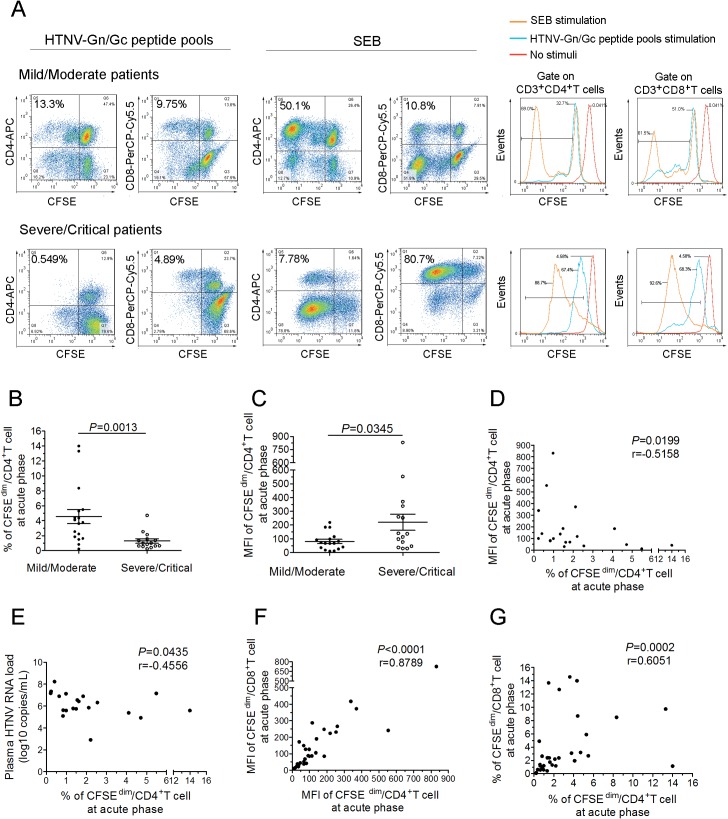
The expansion capacity of HTNV-Gn/Gc-specific CD4+T cells is associated with viremia control in HFRS patients.(A) Representative flow cytometric plots of the expansion percentage of CD4+ or CD8+T cells stimulated by the HTNV-Gn/Gc or polyclonal activator SEB control during acute HFRS. The expansion extent of the HTNV-Gn/Gc-specific CD4+ or CD8+T cells is shown in the upper left quadrants of each figure, reflecting the decrease of CFSE in the dividing CD4+ or CD8+T cells. The numbers denote the percentage of cells within the boxed regions. The overlay of the three conditions in histograms clearly demonstrate that the CFSE curve of both CD4+ and CD8+T cells from the SEB stimulation is shifted more to the right than that stimulated by the HTNV-Gn/Gc. The upper and the lower lanes show the expansion capacities of the representative mild/moderate and severe/critical patient, respectively. (B-C) Comparison of the percentage (B) and MFI (C) of CFSEdim CD4+T cells stimulated by HTNV-Gn/Gc at the acute phase of HFRS between mild/moderate and severe/critical patients. (D) Analysis of the correlation between the percentage and the MFI of CFSEdim CD4+T cells. (E) Analysis of the correlations between the percentage of CFSEdim CD4+T cells and the plasma HTNV RNA load of HFRS. (F-G) The correlation of the MFI (F) or percentage (G) between CFSEdim CD4+T cells and CFSEdim CD8+T cells stimulated by HTNV-Gn/Gc during acute HFRS. Each spot represents a single patient. The Wilcoxon rank sum test and Spearman’s rank test were used for statistical evaluation. SEB, staphylococcal enterotoxin B; MFI, mean fluorescence intensity; CFSE, carboxyfluorescein succinimidyl ester.